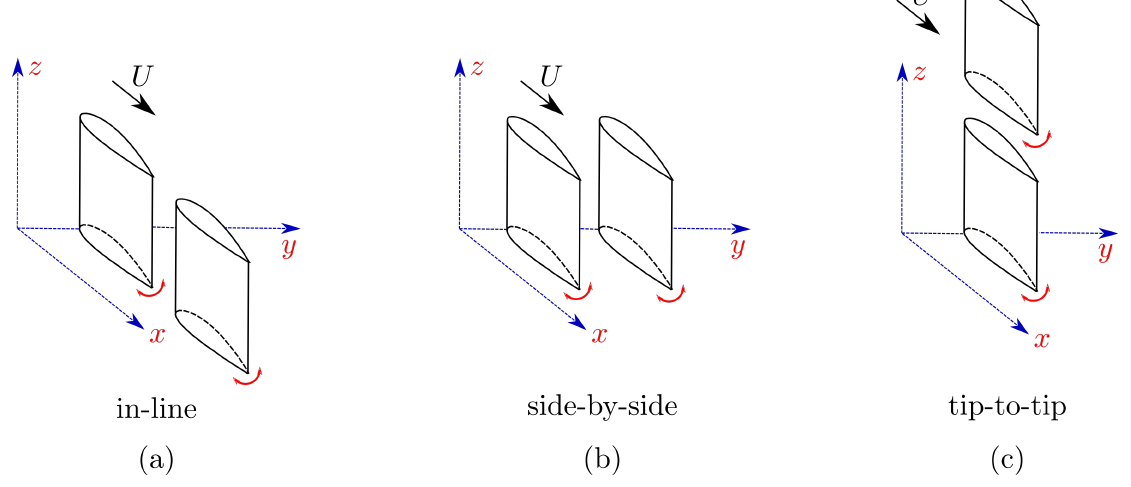
Figure 1. Schematics of the canonical arrangements; in-line ( a ), side-by-side ( b ), and tip-to-tip ( c